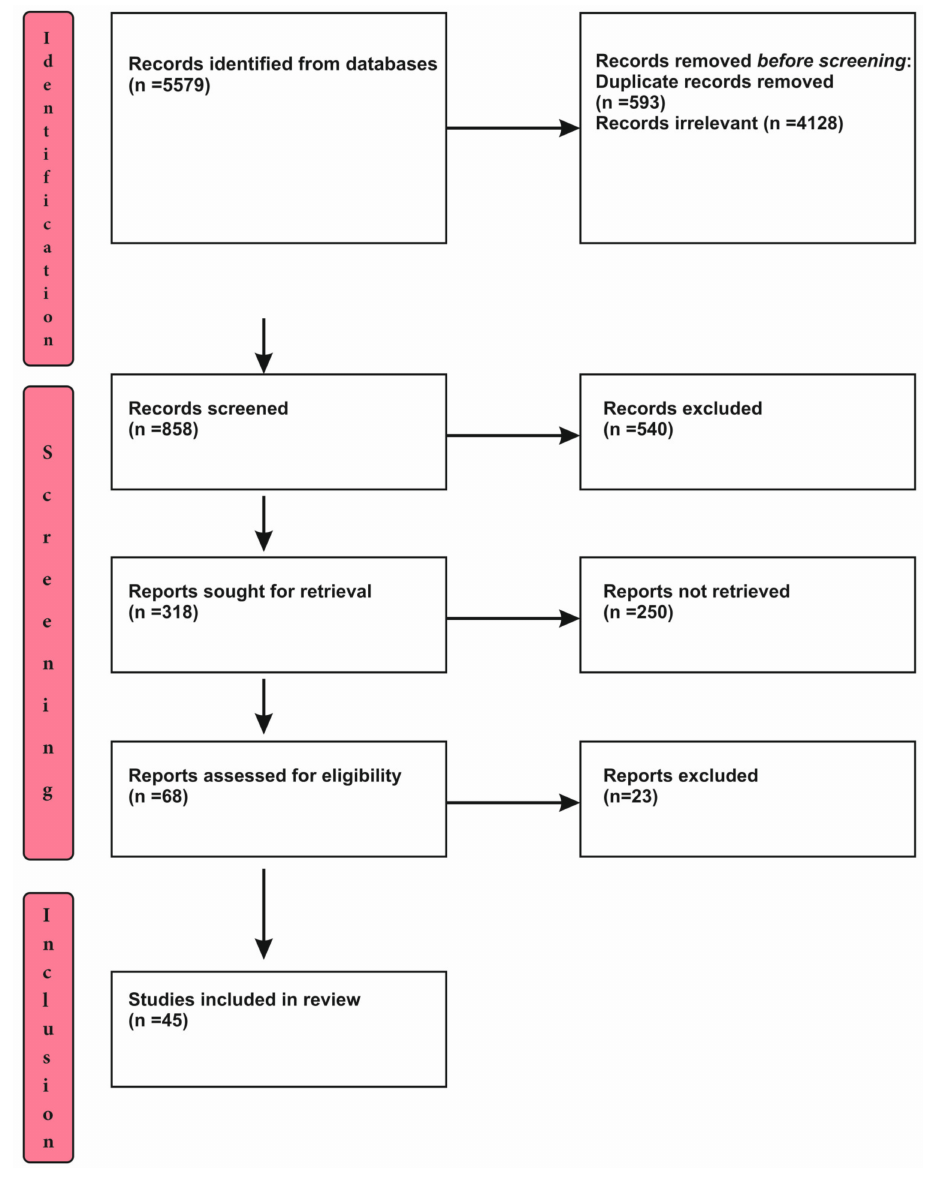
Figure 1. Process of